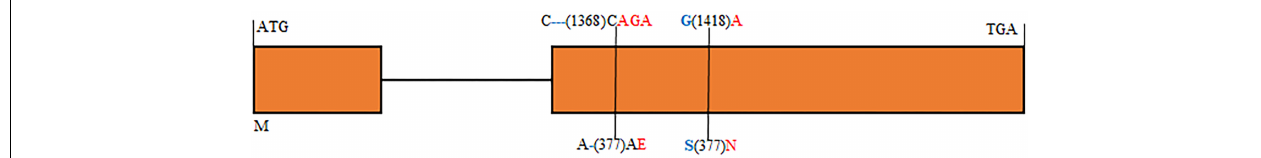
FIGURE 4 | Structure of the annotated gene TraesCS2A02G001500 displaying nucleotide and amino acid sequence polymorphisms between the resistant and susceptible parents. Introns and exons are indicated by lines and orange boxes, respectively. Blue and red color characters indicate alleles of resistant and susceptible parents, respectively. Numbers in parentheses represent the positions of nucleotide and amino acid sequences relative to ATG and M. – Indicates a sequence deletion.